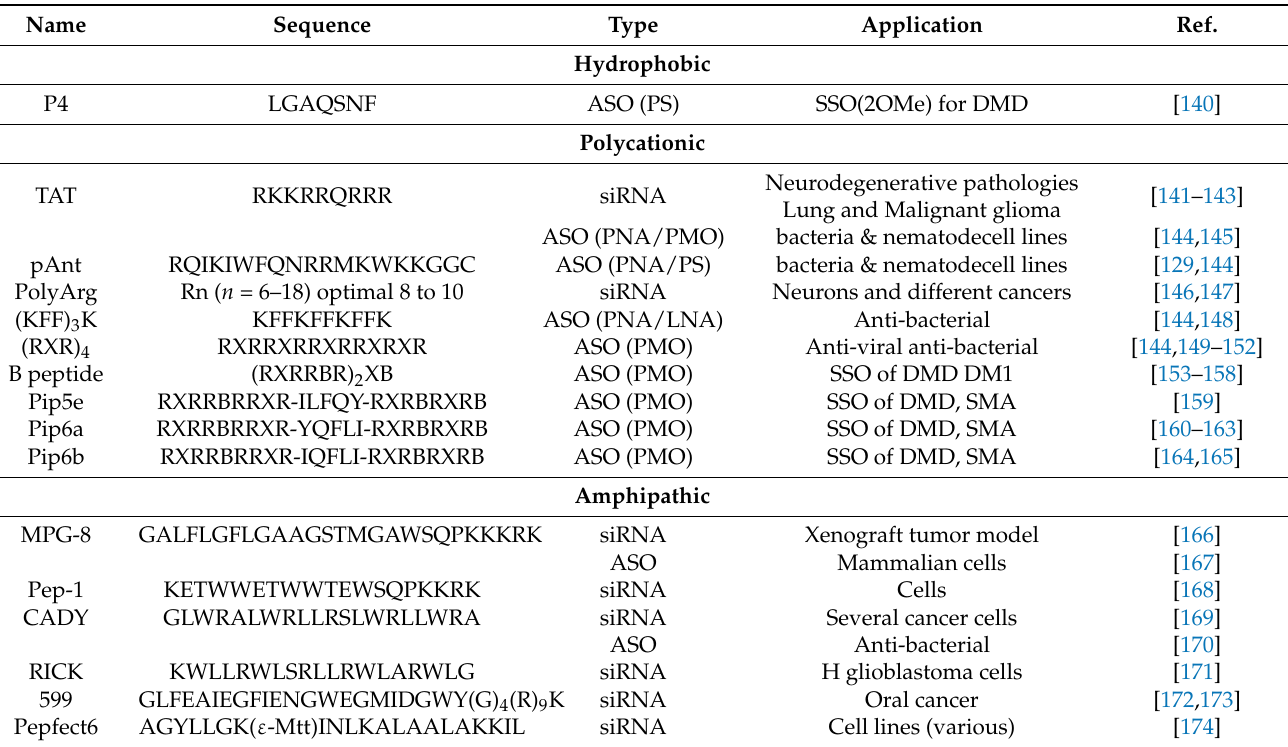
Table 1. Selected sequences of peptides, especially cell-penetrating peptides, that are studied for enhanced oligonucleotides delivery. The two main cellular mechanism of delivery used are direct penetration or energy-dependent endocytosis, described in the main text. Once internalized, some peptide sequences facilitate the endosomal